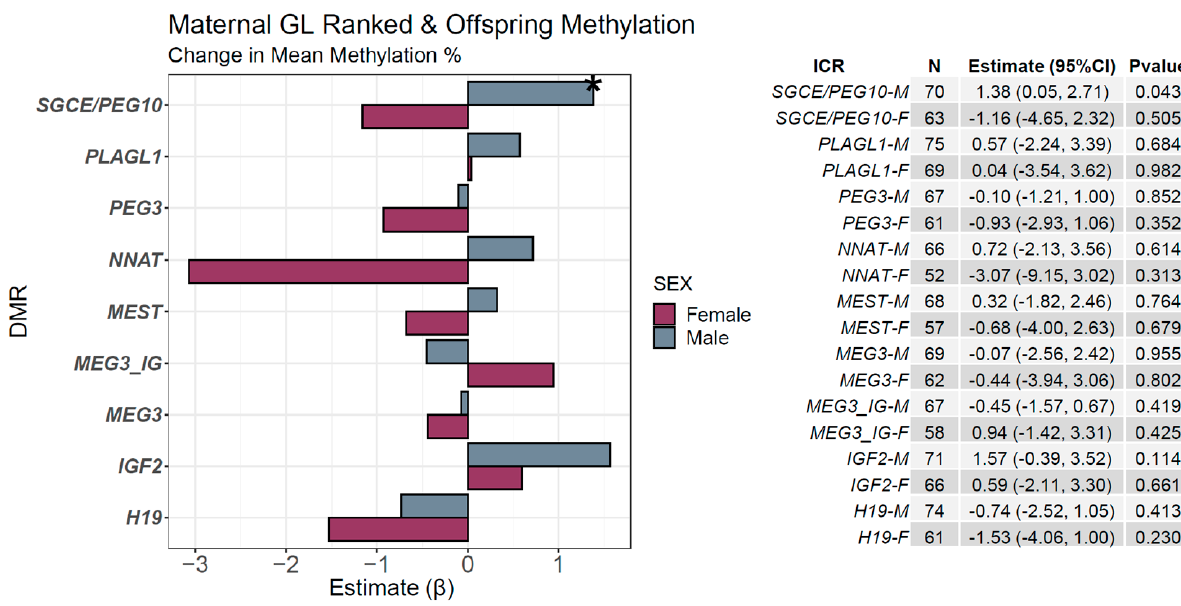
7 of 13 Figure 3. Sex ‐ specific associations of MGL (T3 vs. T1) and offspring temperament. Sex ‐ specific associations with MGL (tertile 3 vs. tertile 1) and offspring behavioral outcomes. For a given tertile of MGL compared to tertile 1 (referent), the odds ratio (95% confidence interval) represents the risk of being in a higher tertile of behavioral outcome. Males (gray) and females (magenta) odds ratios (95% confidence intervals) are plotted. Estimates were adjusted as before stratified by sex. * p < 0.05; † Benjamini–Hochberg FDR < 0.10. 3.3. Imprinted Control Regions (ICRs) for Nine Imprinted Genes and Multiple CpGs To test mediation effects of methylation of control regions of imprinted genes on the association between MGL and offspring behavior we examined the relationship of MGL